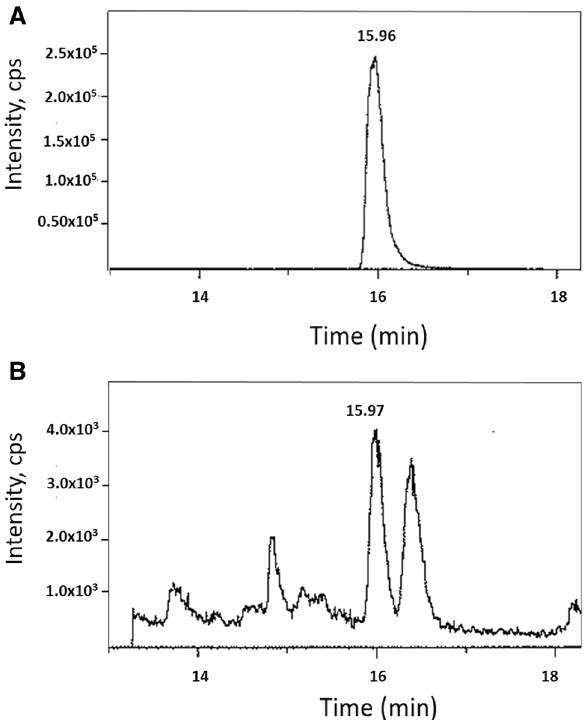
Figure 2. LC–MS/MS analysis of 4-OXO-DHA in rat plasma. ESI negative, transition m/e = 341 → 135. Panel A represents the synthetic standard (5 ng in ethanol), while Panel B represents the detection of 4-OXO-DHA in un-spiked plasma sample from rats that received DHA. In Panel A , 4-OXO-DHA (1 mg) was dissolved in 1 ml ethanol and farther diluted to yield 1 µg/1 ml solution; 5 µl was analyzed. In Panel B , plasma sample (500– 700 µl) from each rat (n = 5) mixed with 500 µl of buffer (1 M sodium acetate, pH 6) and then was extracted 3 times with 2 ml of a mixture consisted with ethyl acetate:hexane:acetic acid (75:24:1). The extract was dried over sodium sulfate, filtered and then evaporated to dryness. The residue was reconstituted in 150 µl of ethanol and 5 µl was analyzed. CPS = counts per second.